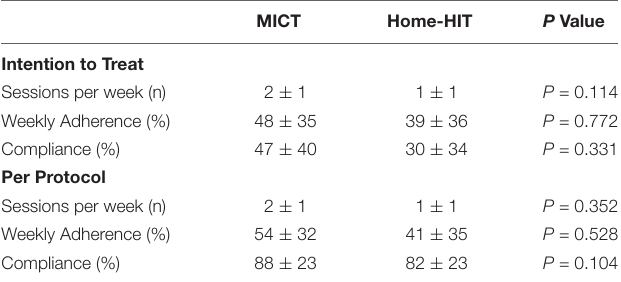
TABLE 6 | Adherence and compliance to the 12-week MICT and Home-HIIT interventions. MICT Home-HIT